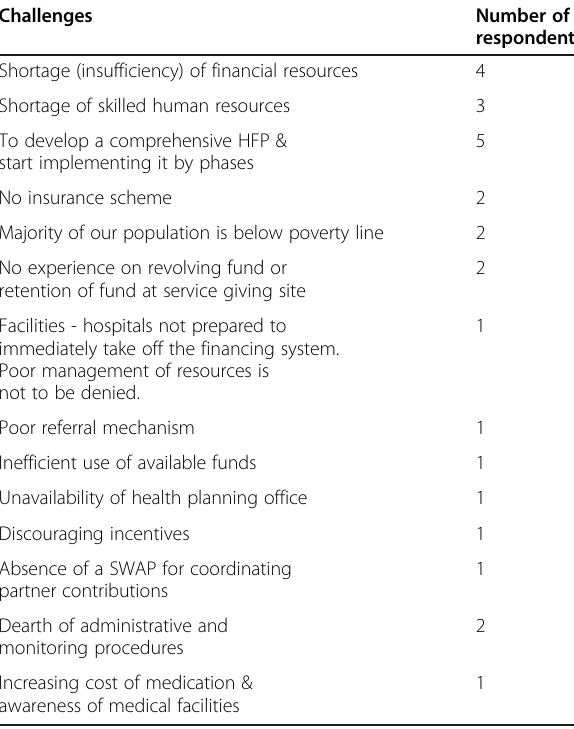
Table 2 Existing local opportunities to strengthen